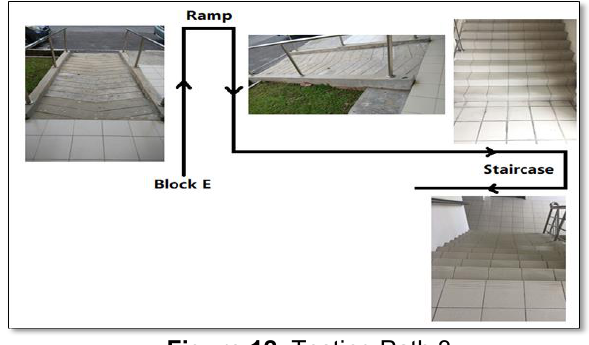
Figure 12. Testing Path 3.